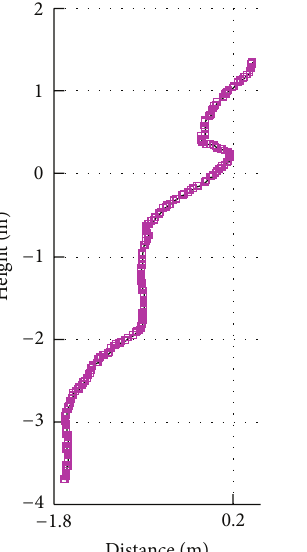
Figure 3: Length and sketch of Profile I-I by stereoscopic model.